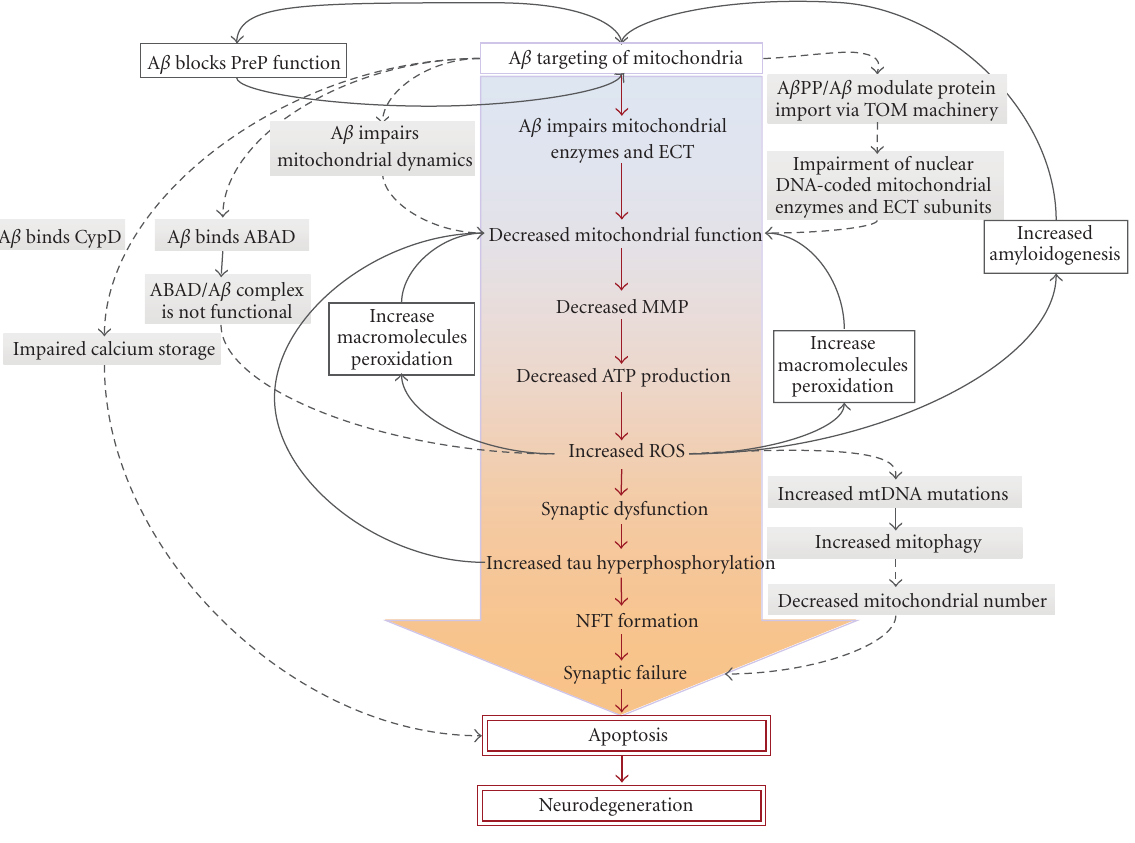
Figure 3: A hypothetical sequence of the pathogenic steps of the Alzheimer mitochondrial cascade hypothesis. The main cytotoxic pathway of A β (red arrows) involves A β -induced mitochondrial function, increased ROS production, activation of neurofibrillary tangles (NFT) formation, synaptic failure, and neurodegeneration. Several other pathways feed this cascade via feeding back (black arrows) or forward (dashed arrows) revealing several vicious cycles within a larger vicious cycle. All of them, once set in motion, amplify their own processes, thus accelerating the development of